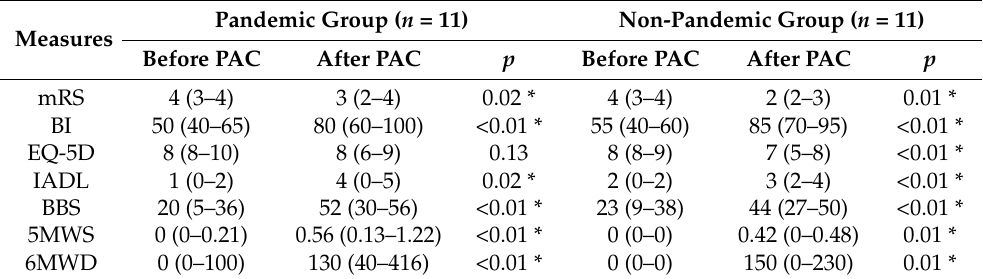
Table 2. Total score for each functional status measure before and after the PAC program in both groups.